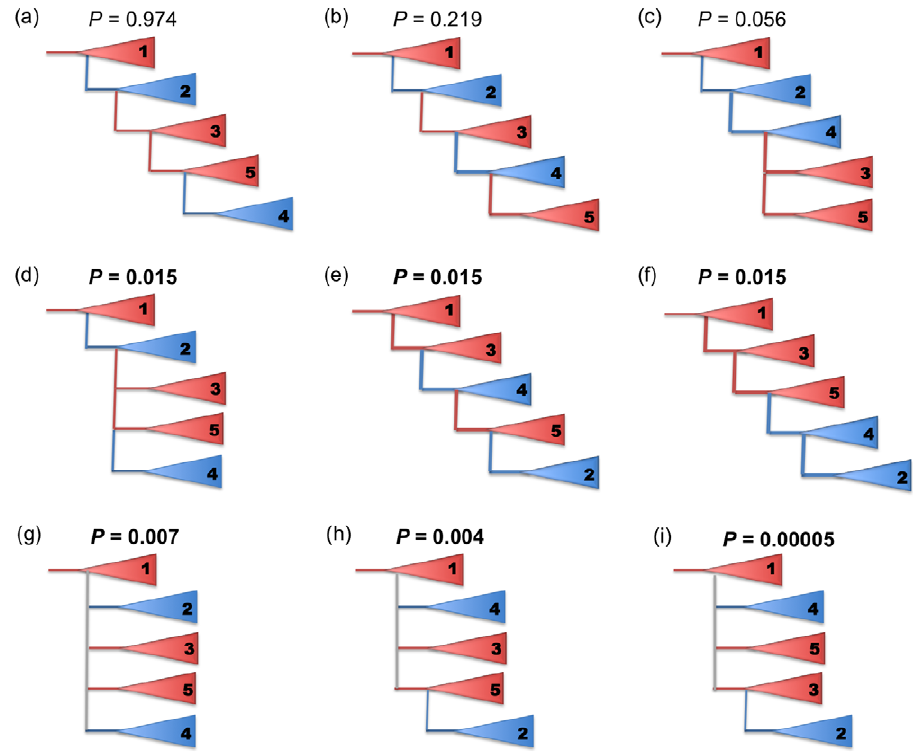
Figure 2. Topologies compared and ranked using an approximately unbiased test of tree selection. Topologies are presented in order of ranking and P -values are shown. The branching order of the only strongly supported ( P =0.974) topology suggests bidirectional movement between the Atlantic (blue) and the Pacific (red). Topologies that have significant P -values at a # 0.05 (shown in bold) can be rejected. This included all those that were not consistent with an allopatric period for the Pacific offshore and resident ecotypes.